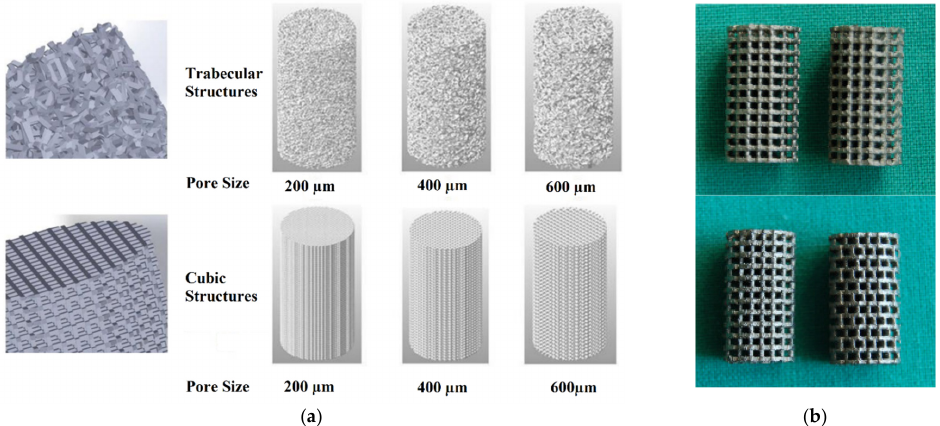
Figure 4. ( a ) Different models of porous samples, the first row of three images shows trabecular structures with different pore sizes, whereas the second row shows cubic structures with different pore sizes. Reprinted with permission from ref. [79]. 2021, MDPI. ( b ) Photographs of 3D scaffolds with identical strut design in x-z and y-z plane (above) and shifted strut orientation (below). Reprinted with permission from ref. [80]. 2012, MDPI.